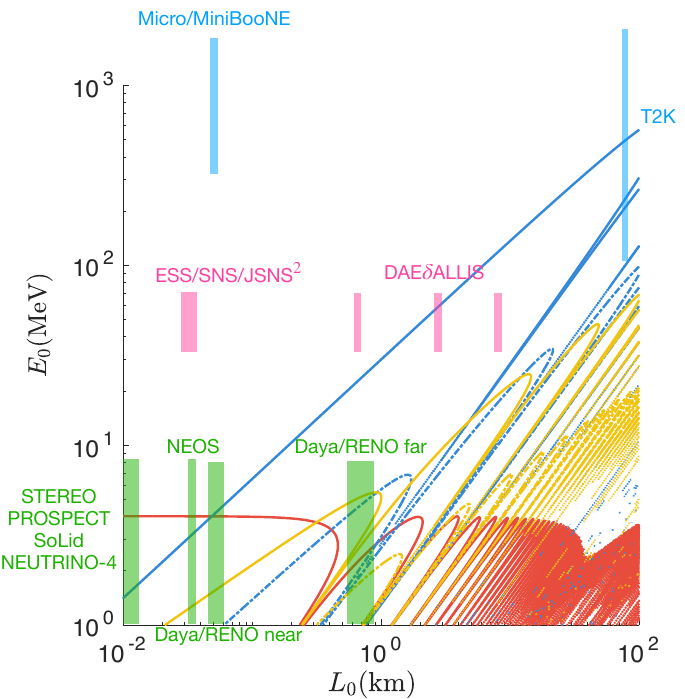
Figure 12 . This figure is plotted to give us an idea on where to find neutrino decoherence effect among current ground-based experiments. The red, blue and yellow lines represent contours of | P ( σ n 6 = 0) − P ( σ n = 0) | = 10 − 6 for the solid lines and 10 − 4 for the dashed lines, for n = L, E and ¯ p , respectively, where the sensitivity would be higher below the lines. We set σ √ σ E = 0 . 1 E 0 MeV and σ ¯ p = 0 . 1 MeV as an example. Additionally, experiments (see [63] for a review) with their corresponding baseline and typical neutrino energies are labeled on the plot, for accelerator neutrinos (blue), decay-at-rest neutrinos (pink) and reactor neutrinos